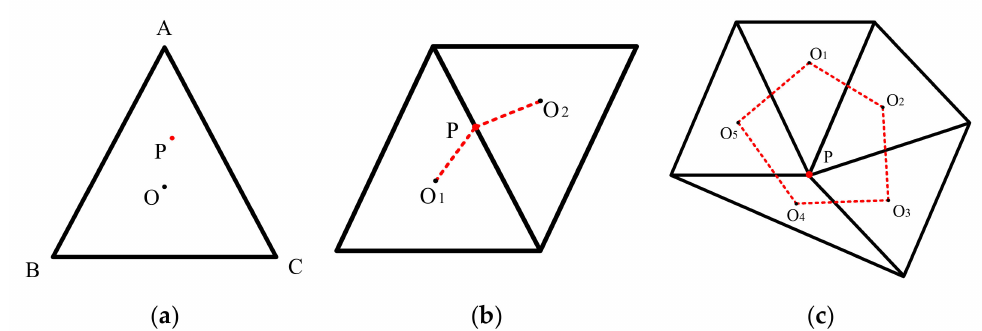
Figure 3. The situations in which the monitoring points are located in different locations: ( a ) Monitor point within a cell; ( b ) Monitor point on the edge of adjacent cells; ( c ) Monitor point at the node of adjacent cells.